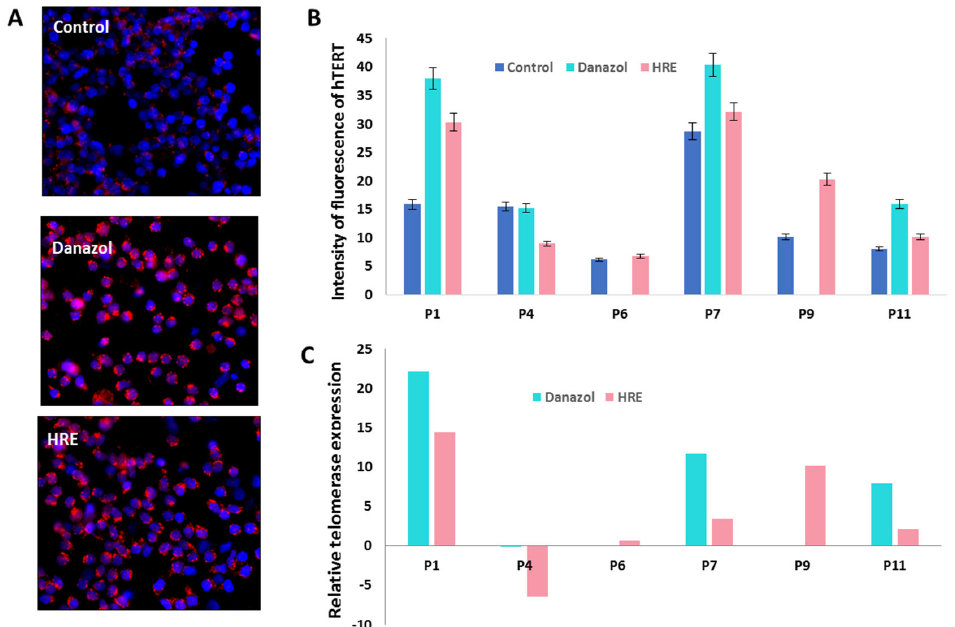
Figure 7. Telomerase expression after exposure to HRE and to danazol. ( A ) Representative image of telomerase reverse transcriptase (hTERT) expression (red) after in vitro treatment of circulating lymphocytes from healthy donors using immunofluorescence staining. Cells were counterstained with DAPI (blue) ( B ) Quantification of the intensity of fluorescence of hTERT protein; 10,000 cells were scored. All data are representative of three independent experiments and are expressed as the mean ± standard error of the mean. The experiments were performed in triplicate. ( C ) Histogram displaying the change in telomerase expression in circulating lymphocytes from healthy donors after exposure to HRE and danazol as a multiple of telomerase expression before exposure to these agents. The absence of hTERT expression for P6 and P9 after danazol treatment was due to a technical